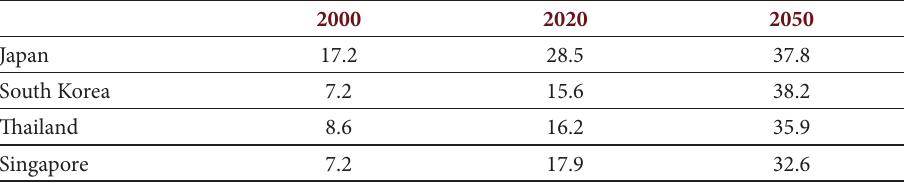
Table 1. Projected share of population over 65 years of age in East Asia (%)